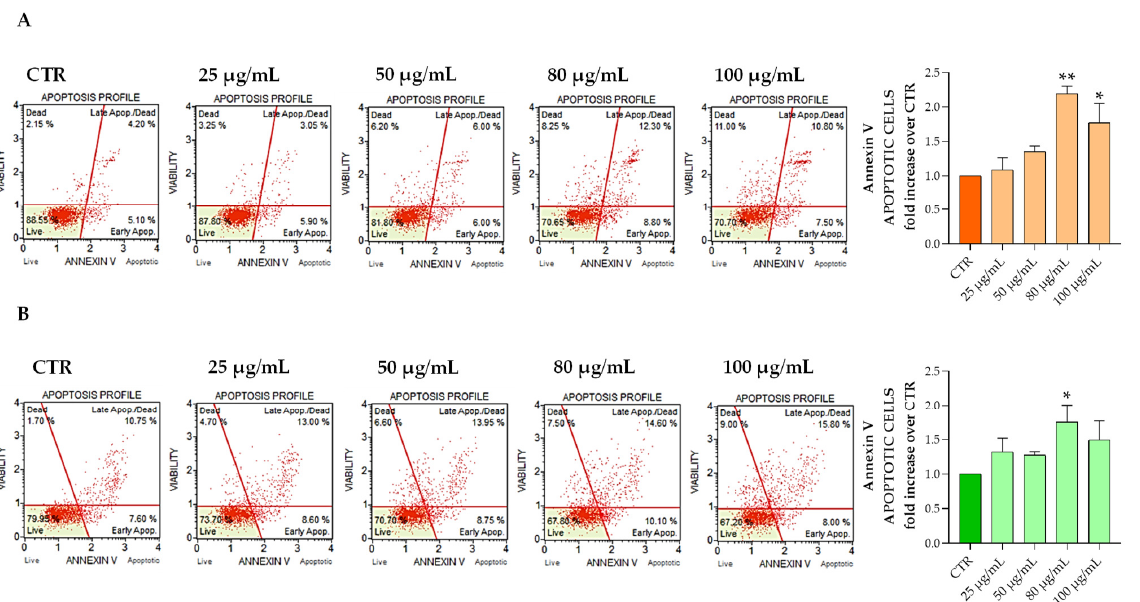
Figure 2. HT29 and SW480 cells cultured with Aglianico GP gastrointestinal digested extract at increasing concentrations for 24 h, processed and analyzed for the percentage of live, early/ late apoptotic, and dead cells by Muse Annexin V assay. The panels represent an example of